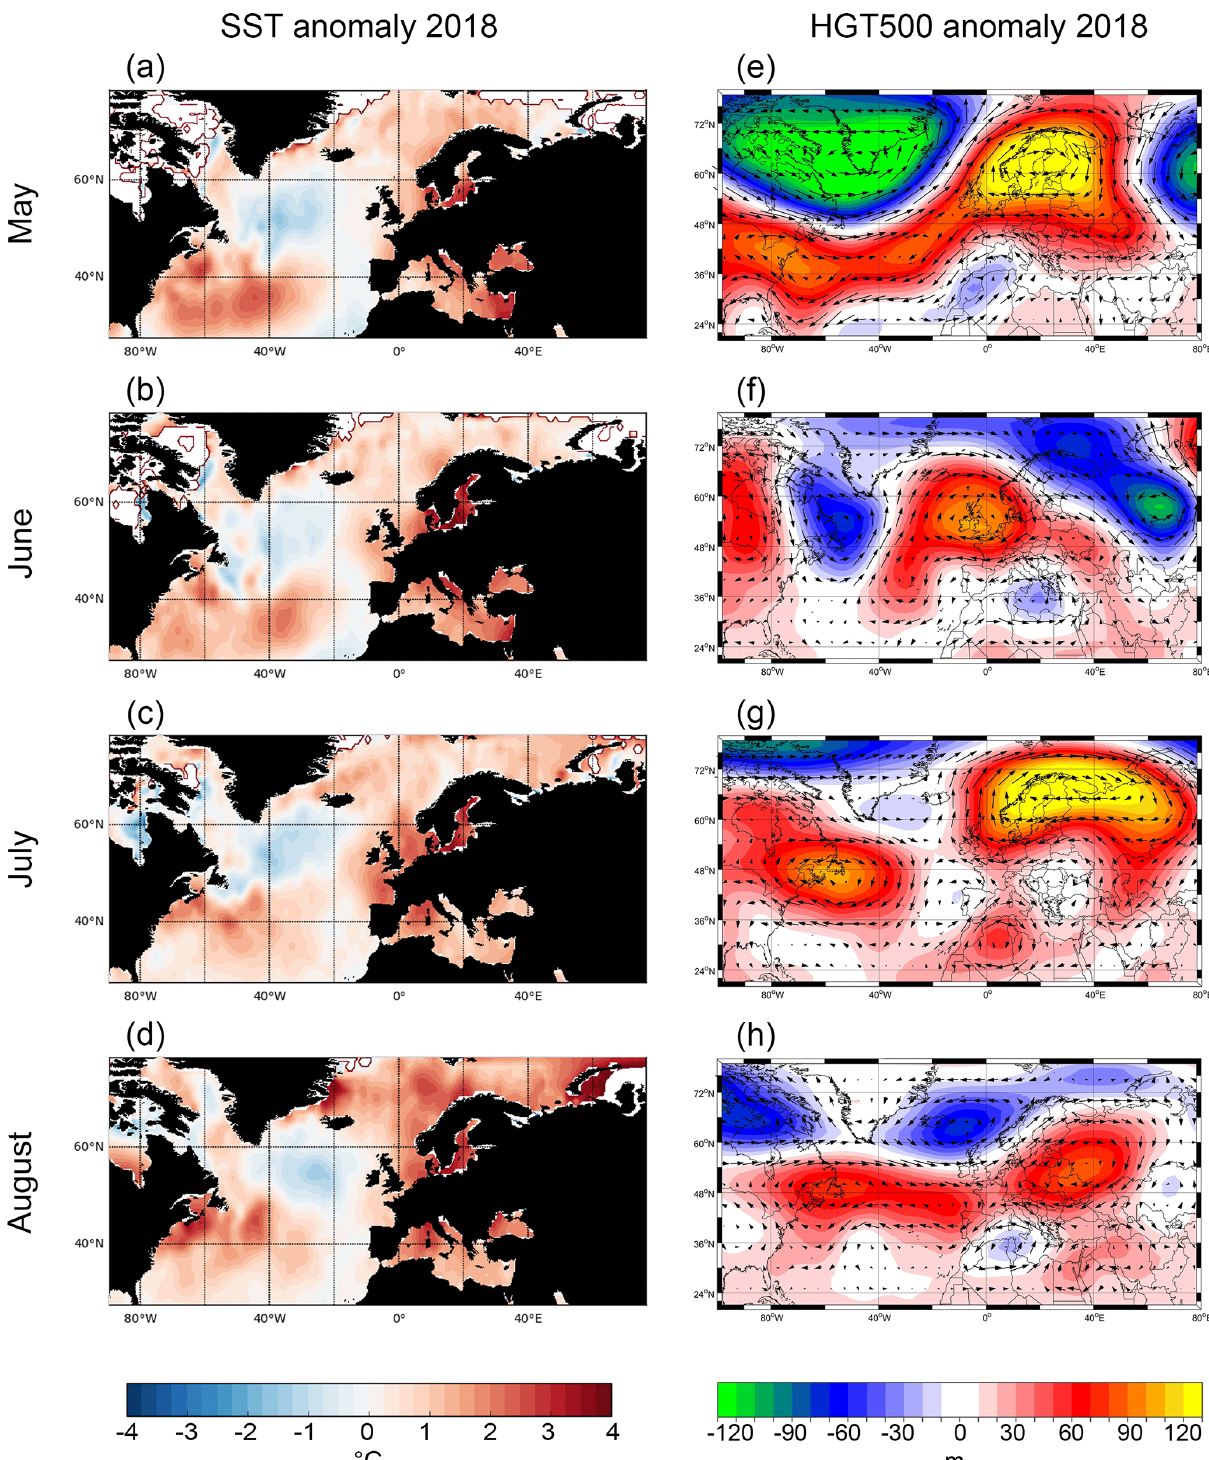
Figure 3. Left panels: sea surface temperature (SST) anomalies for (a) May, (b) June, (c) July, and (d) August 2018 relative to the reference period (1971–2000). Right panel: geopotential height at 500mbar (HGT500) anomalies for (e) May, (f) June, (g) July, and (h) August 2018 relative to the reference period (1971–2000). Zonal and meridional wind at the 500mbar level are added to indicate wind